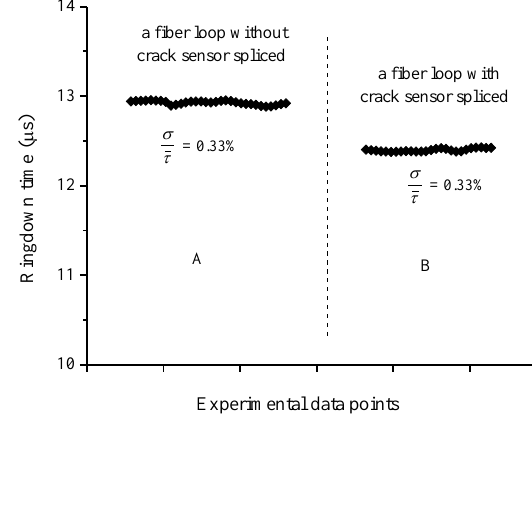
Figure 4. Typical sensor baseline stabilities ( A ) without ( B ) with a sensor head spliced into the fiber loop. Both have the same baseline stability of 0.33% while their baselines are different due to different total